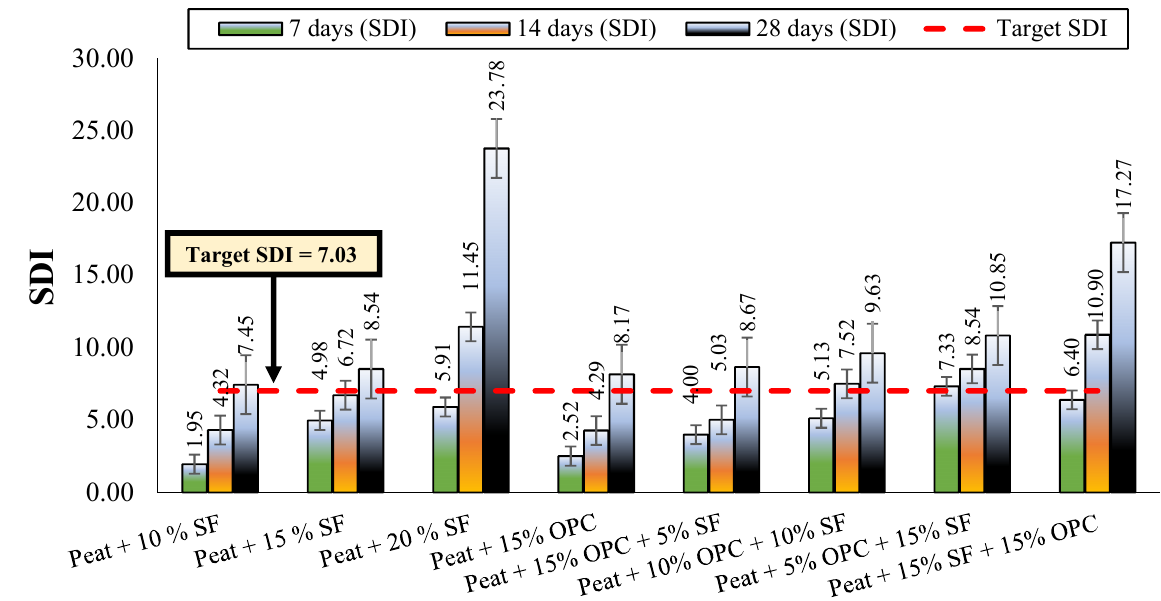
Figure 7. Strength development index (SDI) of all mixes after 7, 14, and 28 days of curing.